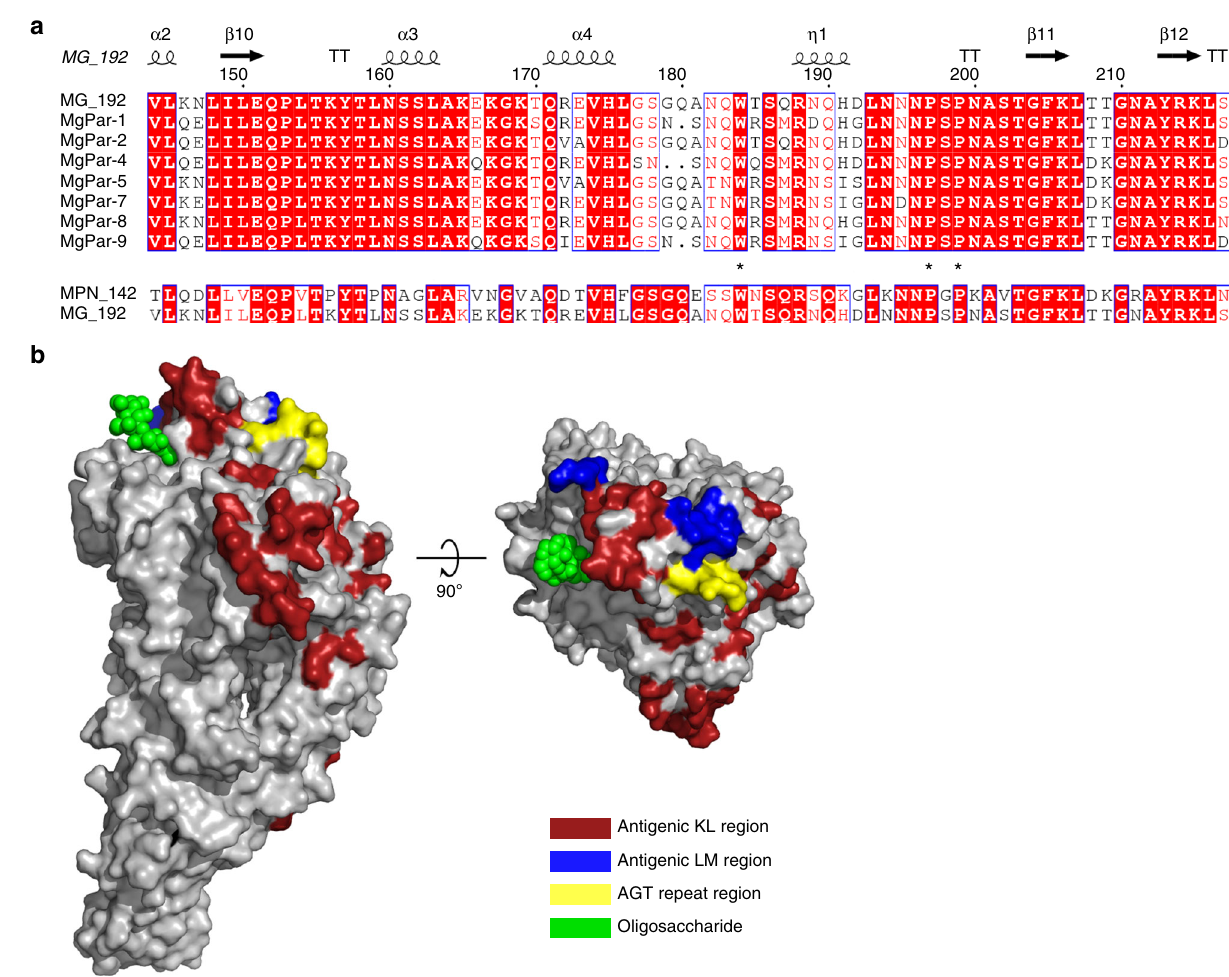
Fig. 6 MgPar regions of P110. a Sequence alignment of the KL variable region of P110 and different MgPars encompassing the sialic binding site. KL region of MgPar-3 carries several STOP codons within the aligned segment and it was not included in the analysis. Similarly, the MgPar-6 region was omitted because it does not contain variable sequences homologous to P110. Residues shown to be critical for cell adhesion in this work (black star) appear to be fully conserved in the KL variable region of all the MgPar repeats. These residues are also conserved in the M. pneumonia protein MPN_142, orthologous to P110 (lower part of the panel). b Two views, 90° apart from each other, of the P110 surface. The KL (residues 42 – 294 in red) and LM (residues 462 – 517 in blue) variable regions and the poly-Serine tract (409 – 419 in yellow) of the P110 protein are depicted. Variable regions surround the receptor binding site where a bound oligosaccharide is shown